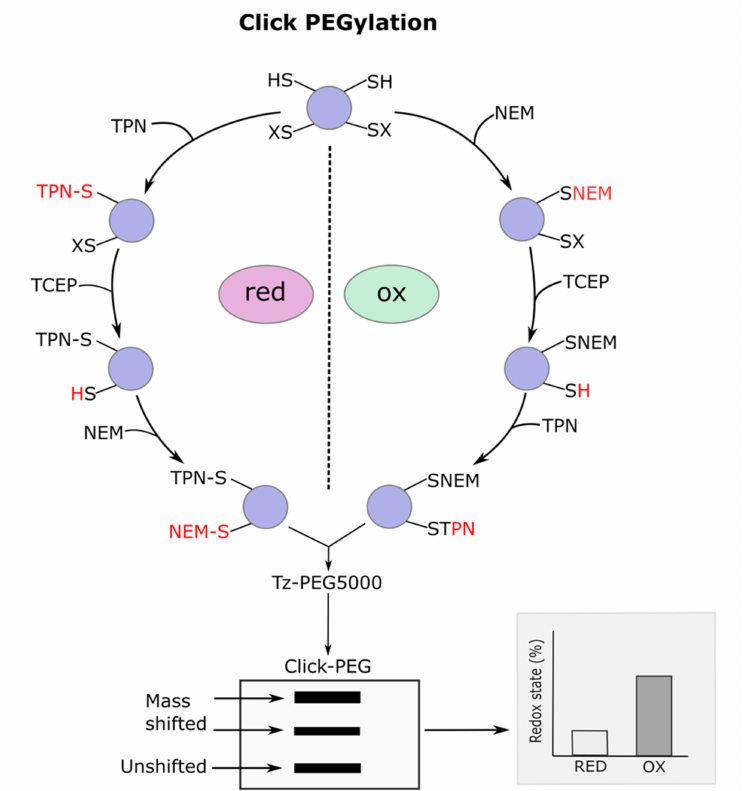
Figure 3. Catalyst-free Click PEGylation schematic. Modified with permission from Cobley et al [116]. The left side of the circle depicts the Click PEGylation reduction (Click-PEGRED) protocol wherein reduced thiols are labelled with TCO- polyethylene glycol 3 (PEG)-maleimide (TPN); (2) before 6-methyltetrazine PEG 5 kDa (Tz-PEG5) is added to initiate the IEDDA Click reaction to mass shift reduced thiols. An optional Tris(2-carboxyethyl)phosphine hydrochloride (TCEP) reduction step to reduce reversibly oxidized thiols before labelling them with N -ethylmaleimide (NEM) is included. The right side of the circle depicts the Click PEGylation oxidation (Click-PEGOX) protocol wherein (1) reduced thiols are labelled with NEM; (2) reversibly oxidized thiols are reduced with TCEP; (3) before being labelled with TPN; and (4) Tz-PEG5 is added to initiate IEDDA Click reaction to mass shift reversibly oxidized thiols. A subsequent Western blot of a target is depicted wherein the Click PEGylated bands are selectively mass shifted. For example, in the Click-PEGOX workflow the mass shifted bands correspond to reversibly oxidized thiols (each one being shifted by approximately 5 kDa) and the unshifted band corresponds to the reduced protein. Following densitometry, percent reversibly oxidized protein can be quantified (as depicted in the